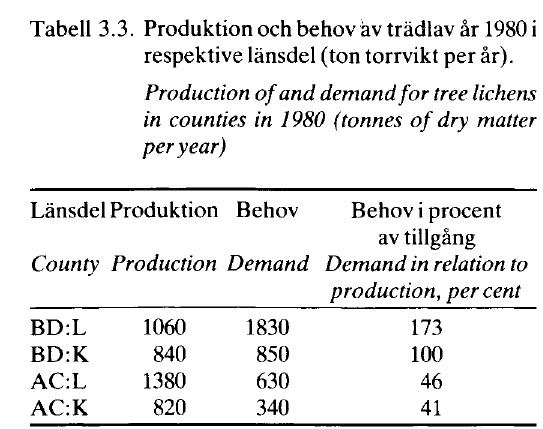
Tabell 3.3. Produktion och behov av trådlav år 1980 i